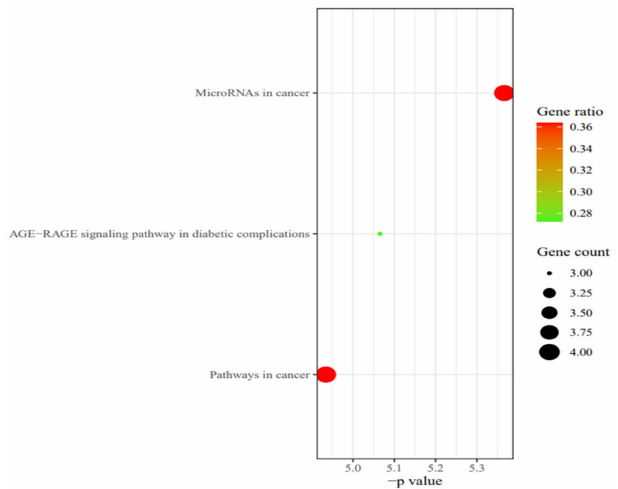
Figure 13. KEGG pathway enrichment analysis bubble map.